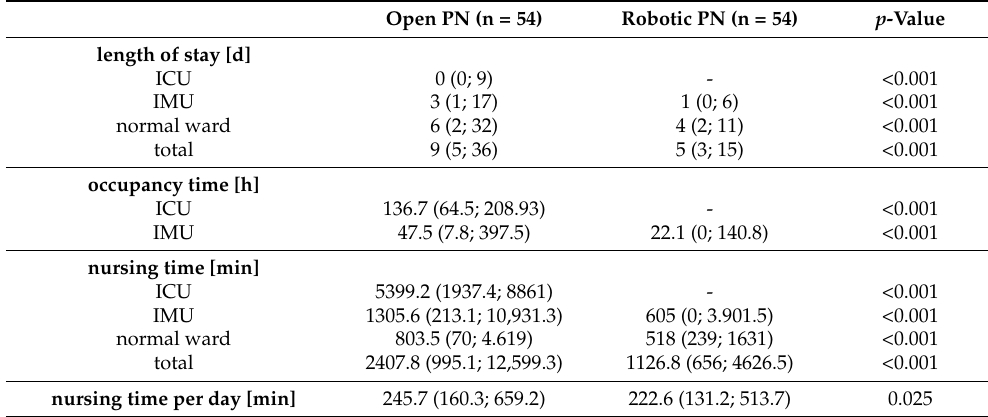
Table 3. Comparison of the nursing care effort of open vs. robot-assisted partial nephrectomies (PN) in the propensity-score-matched analysis.